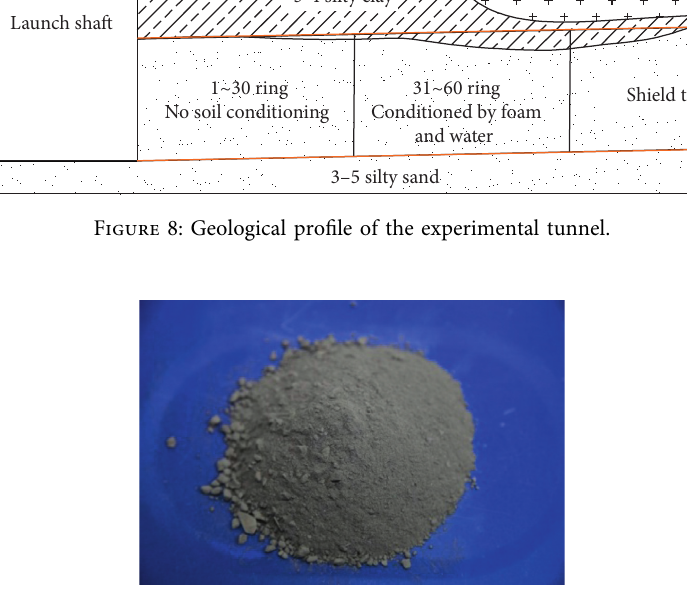
Figure 9: Test sample of silty sand from the tunnel site. Table 1: Physical and mechanical parameters of